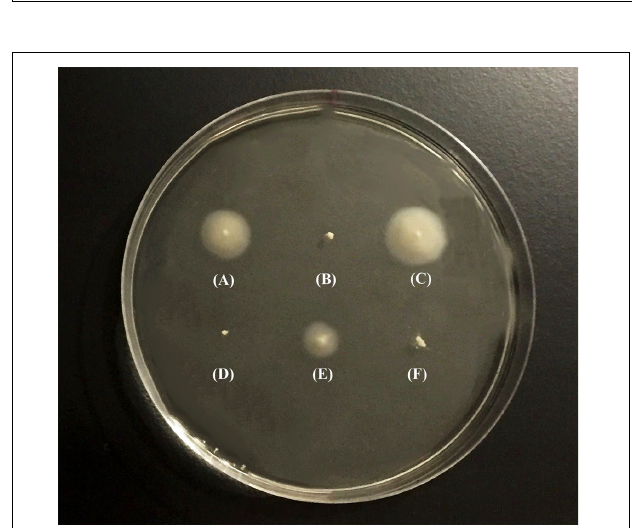
FIGURE 2 | Swarming behavior of V. cholerae strains. Swarming behavior of V. cholerae strains was examined on motility agar (0.3% soft agar). Bacterial strains were individually grown overnight in L-broth at 37 ◦ C before inoculating them into motility agar. After inoculation, the plates were incubated at 37 ◦ C for 8 h and photograph of the culture plate was taken following incubation. (A) V. cholerae N16961S, (B) N16961S (cid:49) flrA , (C) N16961S (cid:49) flrA /pAA146, (D) GS (cid:49) flrA , (E) GS (cid:49) flrA /pAA146, and (F) N16961S (cid:49) flaA .